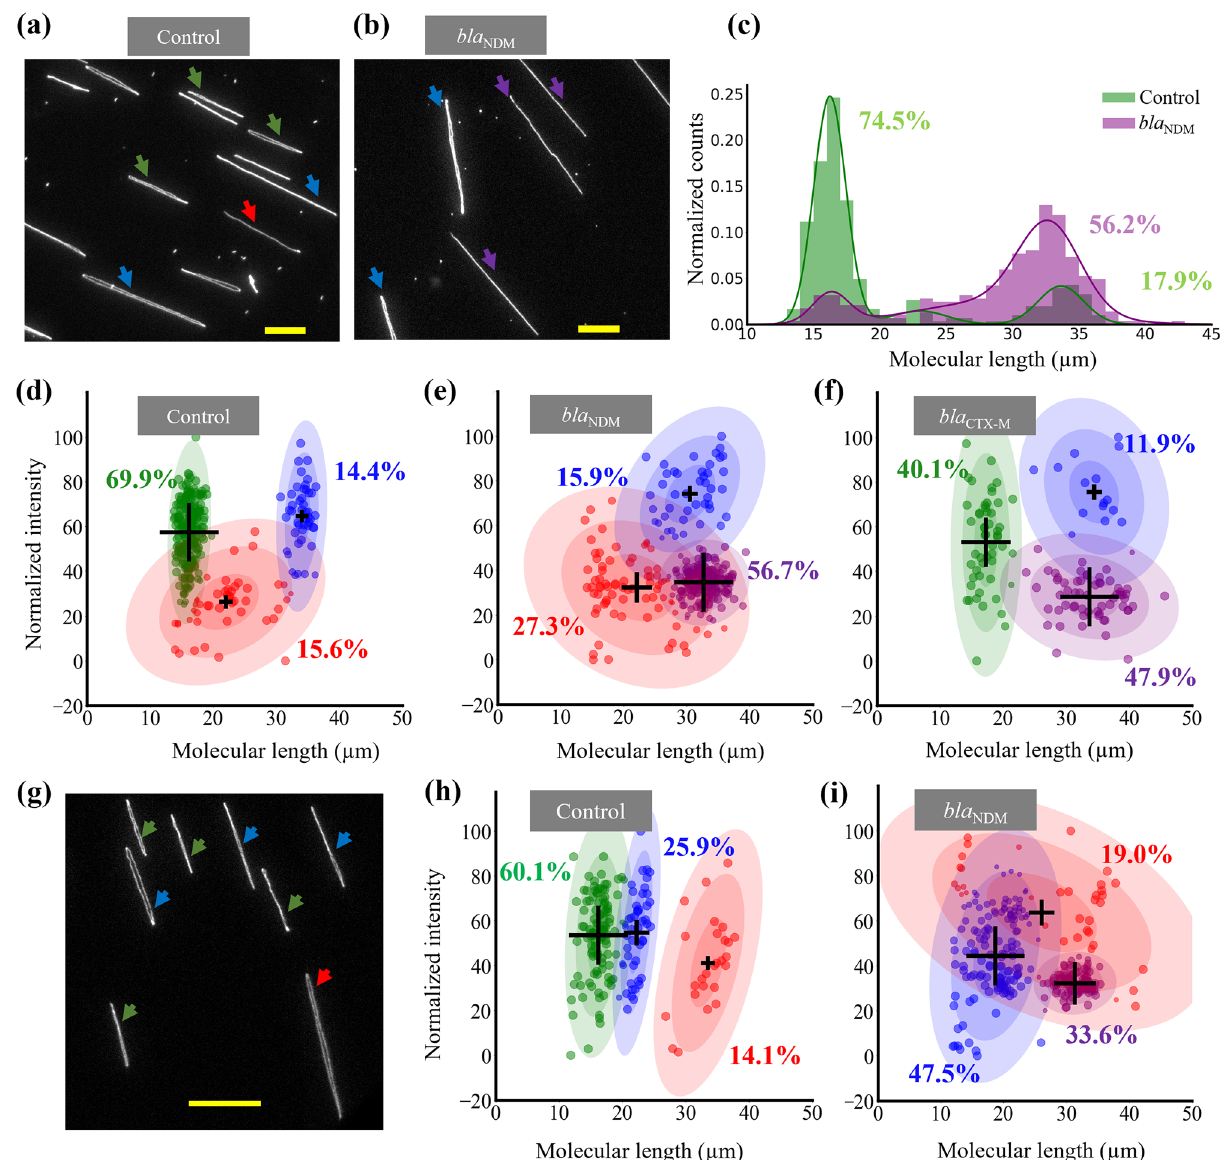
Figure 2. Extended-spectrum β-lactamase and carbapenemase genes in samples with multiple plasmids. Representative images of plasmids after control ( a ) and bla NDM ( b ) reactions. In the control case, two circular populations (green and blue arrows) were observed, along with linear molecules (red arrow). After the bla NDM reaction ( b ), two plasmid populations of similar lengths (blue and purple arrows), but different emission intensities, were observed. Scale bars 10 µm. ( c ) Length distribution of plasmids after control and bla NDM reactions for the control sample (green histogram) and the bla NDM reaction (purple histograms) ( d – f ) Scatter plots with GMM clustering after control ( d ), bla NDM ( e ) and bla CTX-M group 1 ( f ) reactions, respectively. ( g – i ) Carbapenemase gene detection in a sample with three plasmids. ( g ) Representative image showing plasmid composition of the sample. The three different sized plasmids are marked with green, blue and red arrows. All molecules in the image are circular. Scale bar 15 µm. ( h – i ) GMM clustering results for the three-plasmid sample after the control reaction ( h ) and after the bla NDM reaction ( i ). The population clusters identified by the algorithm are presented in different colors in the scatter plots. The mean values are marked with the ‘ + ’ signs (scaled to the weights of the clusters). The percentage values represent the percentage of the population in that cluster. The colored ellipses around the clusters represent standard deviations of the mean. The sizes of the dots are scaled to the probability of belonging to that